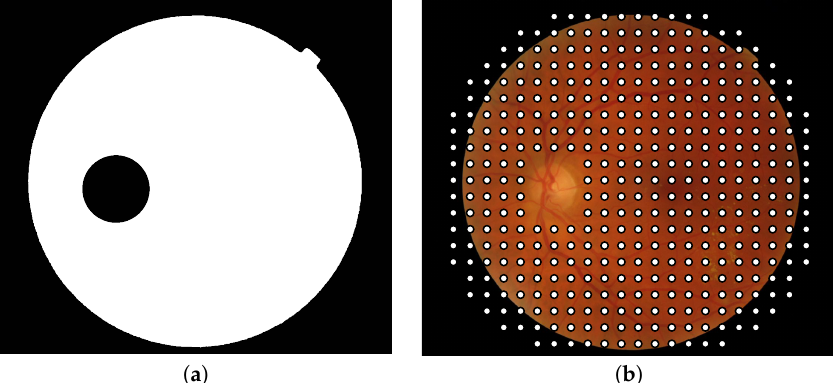
Figure 3. ( a ) Binary mask used to exclude the patches containing optic disk pixels and the patches located out of the field of view and ( b ) center of the patches composing the final grid in which image descriptors will be